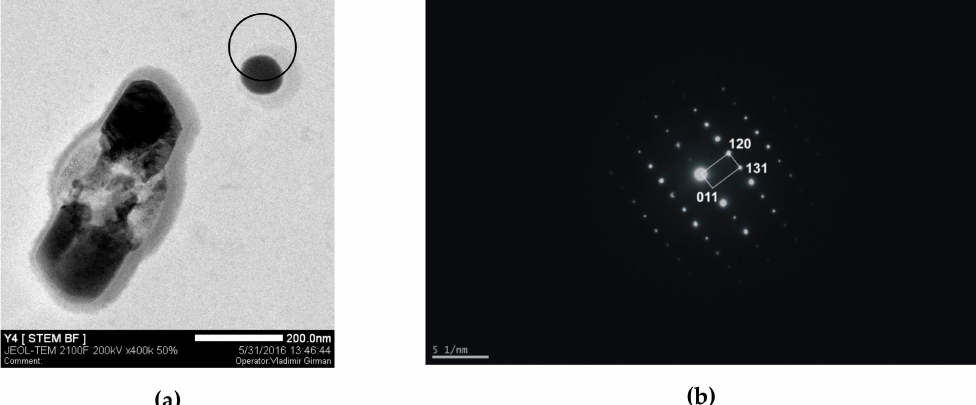
Figure 10. ( a ) TEM, particles in sample Y4, CT1150-2 ◦ , spherical particle on the basis of P, Fe, Nb, Ti, O,